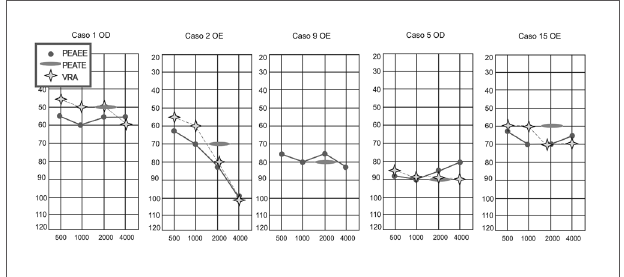
Figura 1. Exemplos de casos da comparação dos PEATE-clique com os PEAEE I. - PEAEE: Potenciais Evocados Auditivos de Estado Estável; PEATE-clique: Potencial Evocado Auditivo de Tronco Encefálico com o estímulo clique; VRA: Audiometria de Reforço Visual. Vale ainda ressaltar que, embora os PEATE-clique sejam amplamente utilizados na rotina clínica para